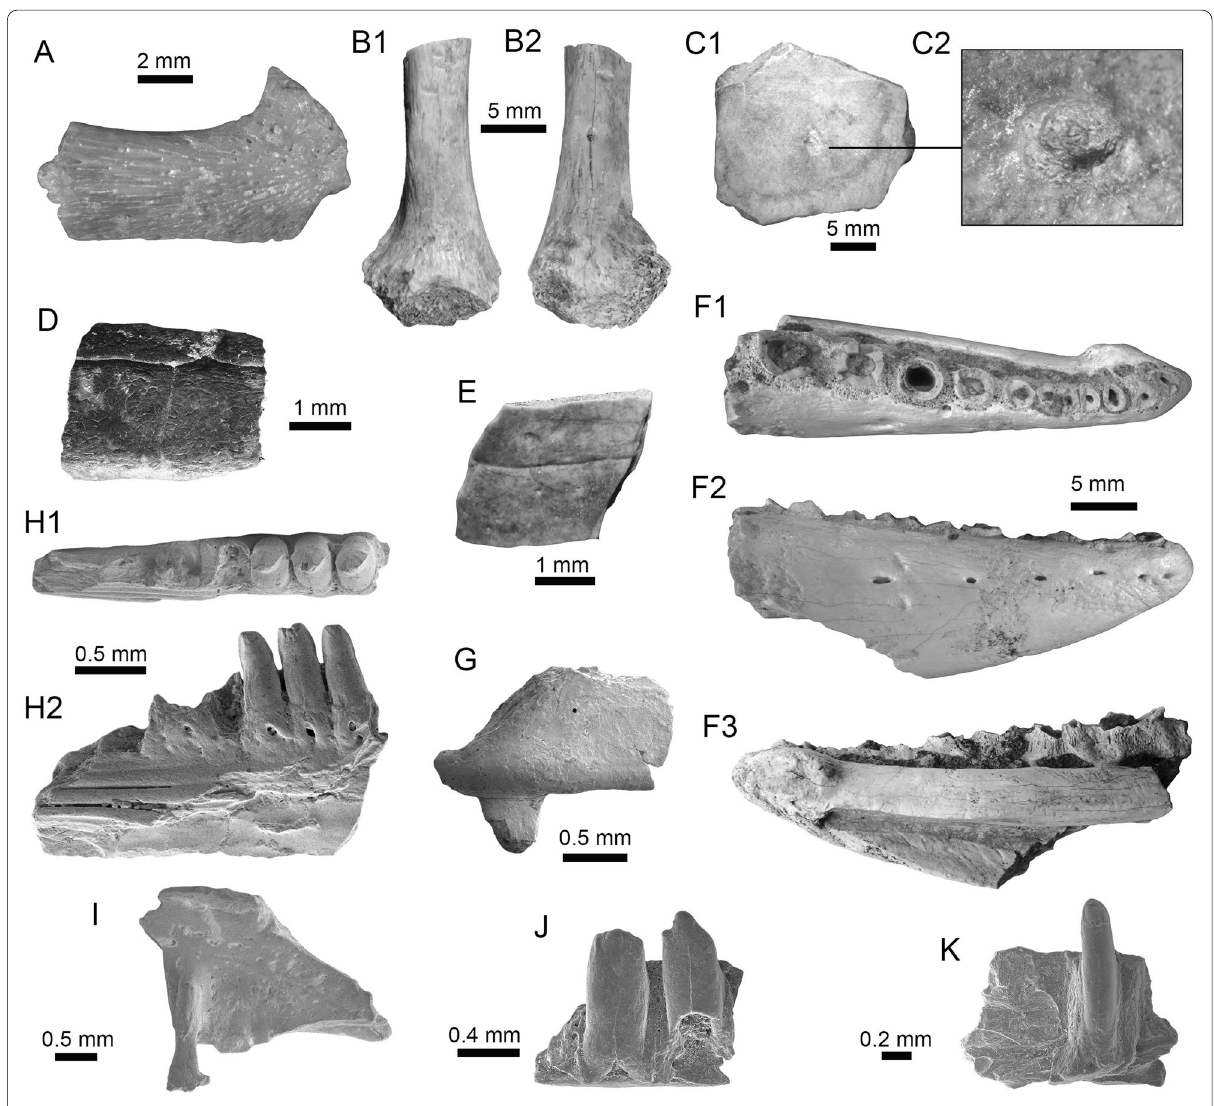
Fig. 16 Testudines indet. and (non‑snake) Squamata from the Vergel Member. A – E Testudines indet. A Fragment of a right premaxilla (AMU‑CURS‑1154). B1 , B2 Distal section of a left fibula (AMU‑CURS‑1160). C1 , C2 Plastron fragment with a bite mark (AMU‑CURS‑862). D , E Shell fragments ( D AMU‑CURS‑842 and E AMU‑CURS‑842). F1 – F3 Fragmentary right dentary of Tupinambis s.l. (AMU‑CURS‑721). G – K (Non‑snake) Squamata indet. G Anterior section of a left maxilla (AMU‑CURS‑1148). H1 , H2 Right jaw fragment preserving three complete teeth (AMU‑CURS‑1164). I Premaxilla fragment with an incomplete tooth (AMU‑CURS‑1163). J , K Two maxilla fragments ( J AMU‑CURS‑725 and K AMU‑CURS‑797). Views: anterior ( B2 ), external ( C1 – E ), left lateral ( G ), right lateral ( A , F2 ), mesial ( F3 , H2 , I – K ), occlusal ( F1 , H1 ), and posterior ( B1